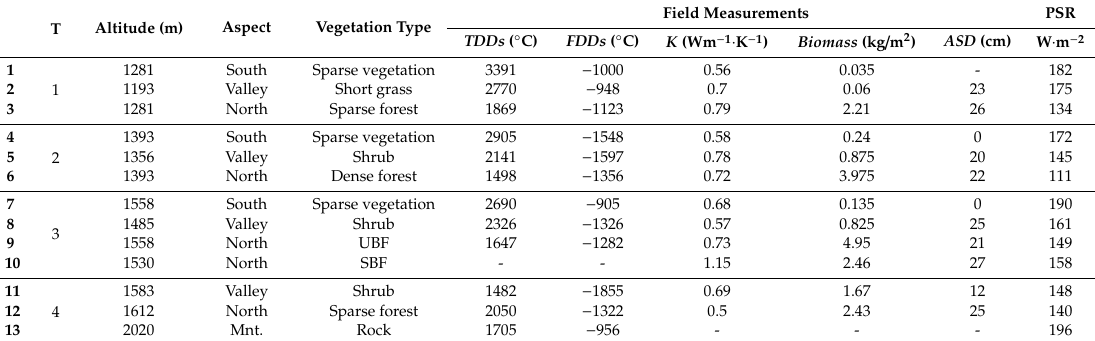
Table 2. Summary of the observed ground surface temperature from iButton and field measurements in Sugnugur catchment for the year 2016–2017. TDD s and FDD s stand for surface thawing degree-days and surface freezing degree-days, respectively. K and ASD represent soil thermal conductivity at 20 cm and accumulated snow depth. T denotes the transect number, while PSR stands for daily potential solar